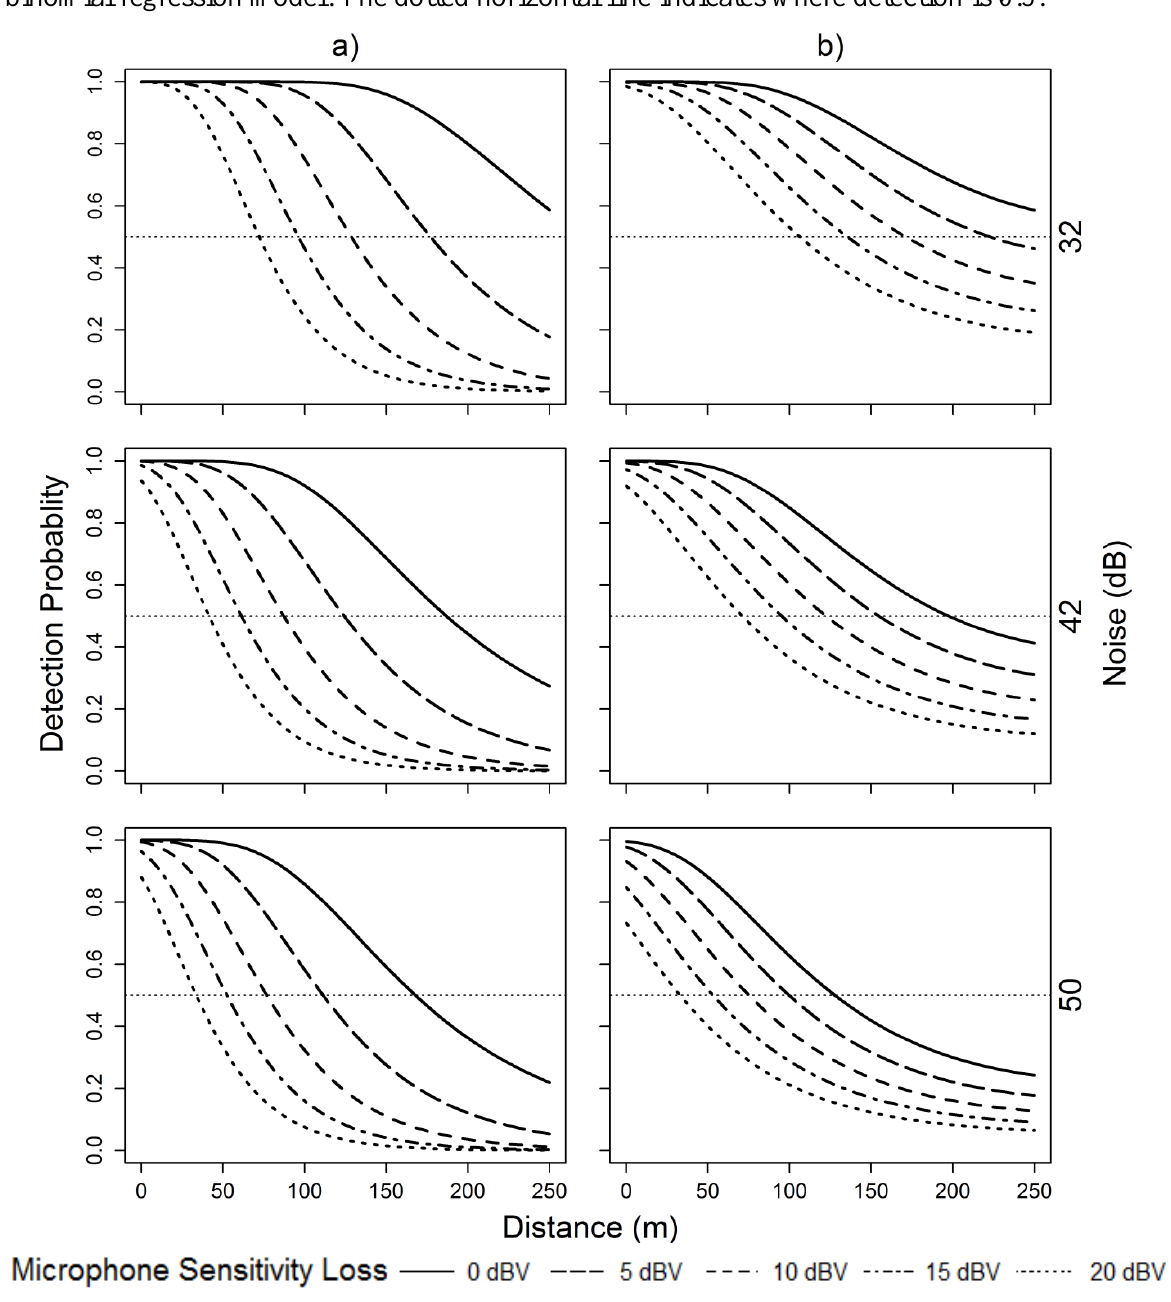
Figure A4.6. Detection probabilities of a) American Bittern and b) Pied-billed Grebe calls for five levels of microphone sensitivity loss and under three noise conditions based on selected binomial regression model. The dotted horizontal line indicates where detection is